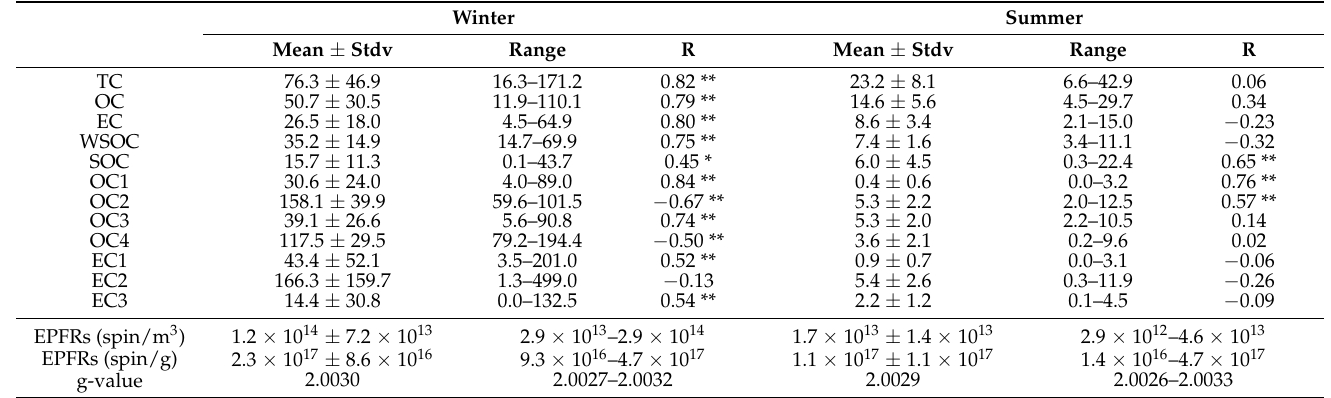
Table 1. Mean and range with a standard deviation of carbonaceous species ( µ g/m 3 ) in PM 2.5 , EPFRs (spin/m 3 ) and EPFRs (spin/g), and correlation coefficient (R) of carbonaceous species with EPFRs (spin/m 3 ) in Lahore during winter and summertime sampling, 2019.